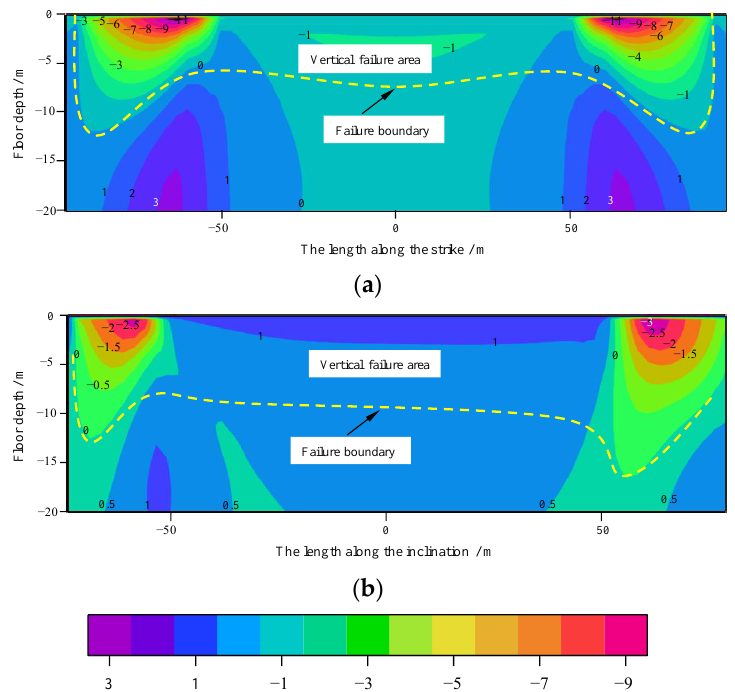
Figure 5. The theoretically obtained failure ranges of floor strata resulting from mining and hydraulic pressures. ( a ) A case with horizontal strata; ( b ) A case with inclined